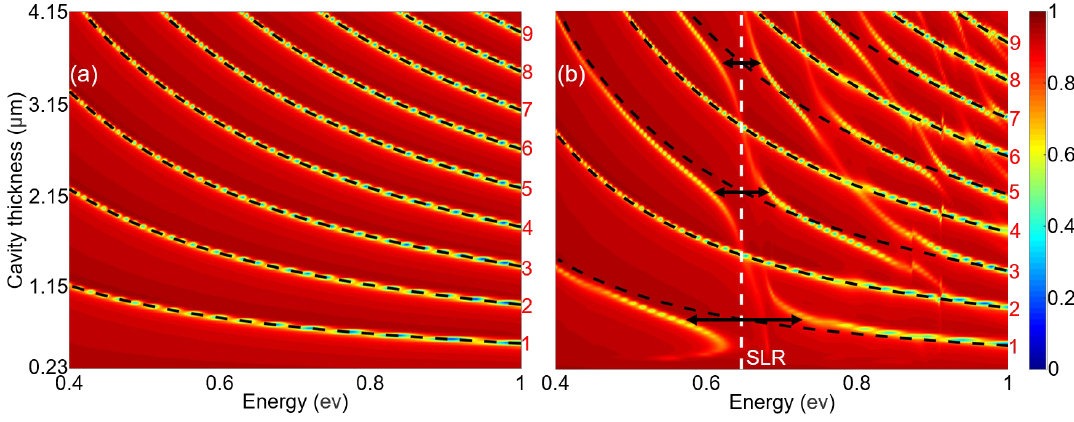
Figure 2. Simulated reflectance spectra of ( a ) the unperturbed F-P cavity and ( b ) the proposed structure formed by periodic metal nanorods placed in the middle of the microcavity with different cavity lengths. The F-P resonances are indicated by black dashed curves in ( a , b ), and the SLR wavelength is indicated by the vertical white dashed line in ( b